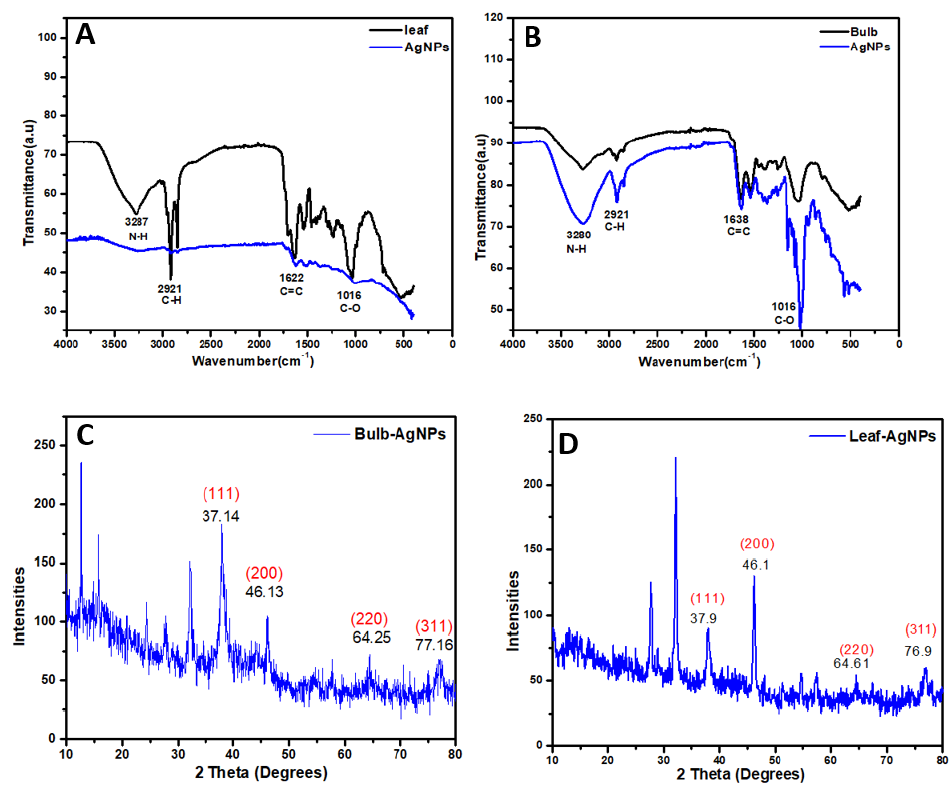
Figure 5. FTIR of leaf-capped AgNP ( A ) and bulb-capped AgNP ( B ) extracts of A. vittata . XRD anal- ysis of bulb ( C ) and leaf synthesized AgNPs ( D ) using A. vittata. analysis of bulb ( C ) and leaf synthesized AgNPs ( D ) using A. vittata